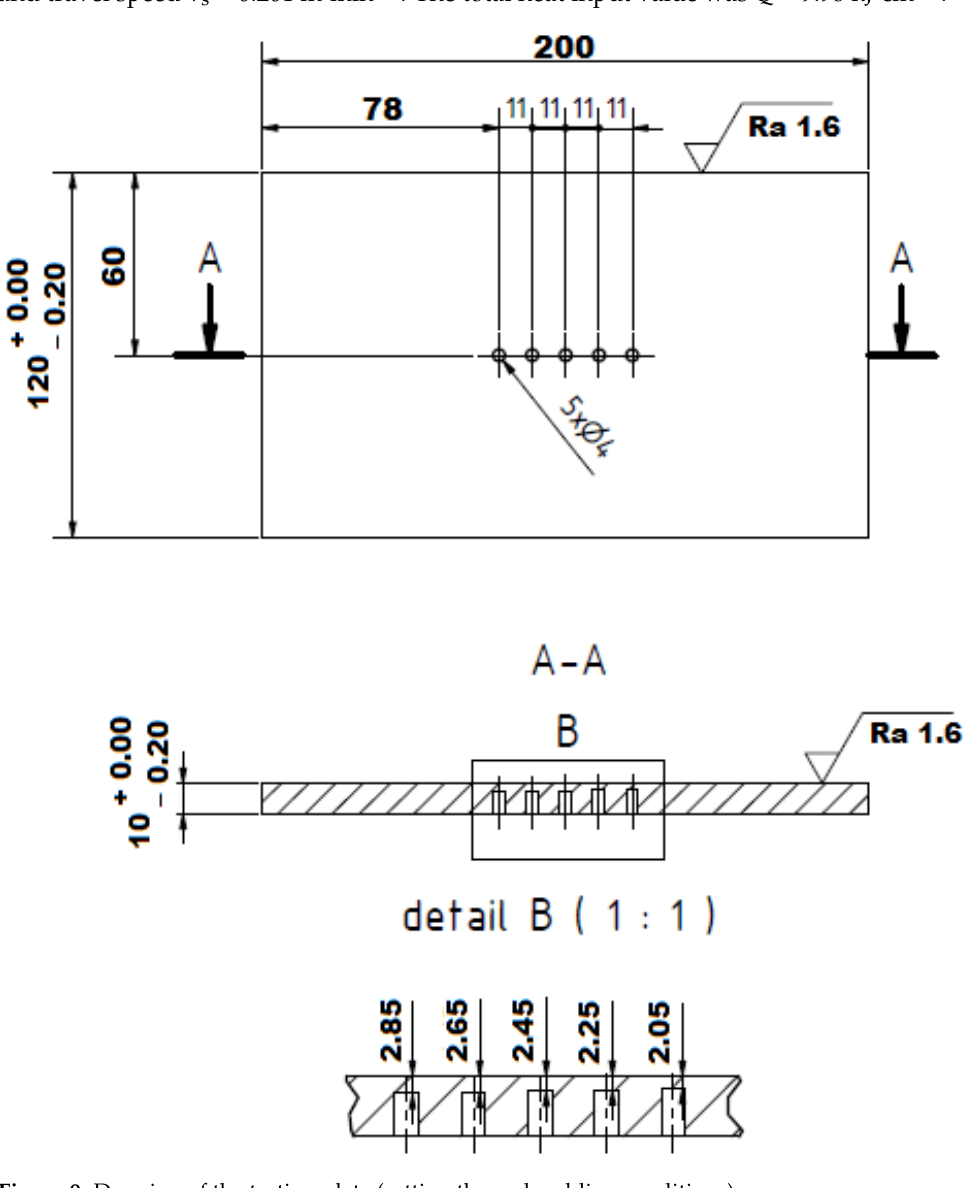
Figure 9. Drawing of the testing plate (setting the real welding conditions).